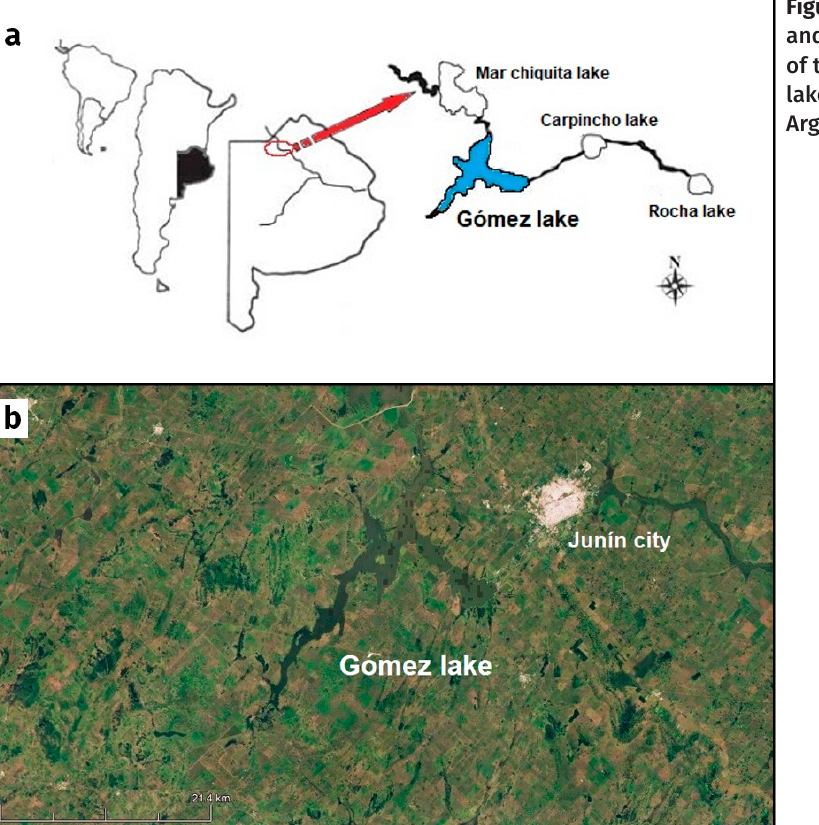
Figure 1. (a) Schematic and satellite diagram (b) of the location of Gómez